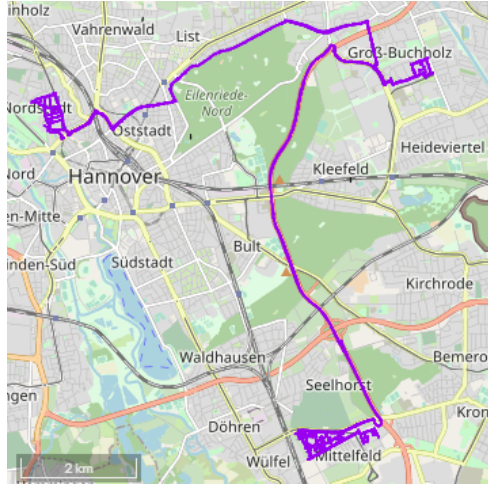
Figure 1. Trajectory of the recording vehicle shown in purple, with a length about 16 km. The base map is provided by © OpenStreetMap.